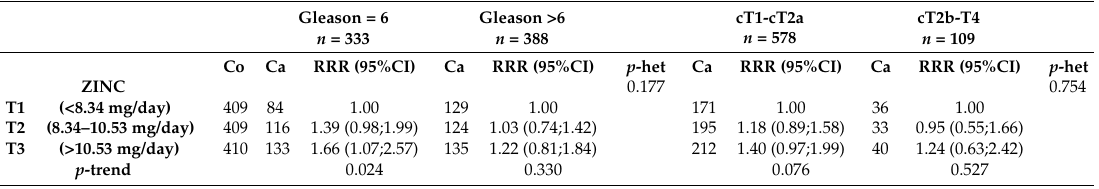
Table 3. Association between dietary zinc and prostate cancer by tumor aggressiveness and extension.